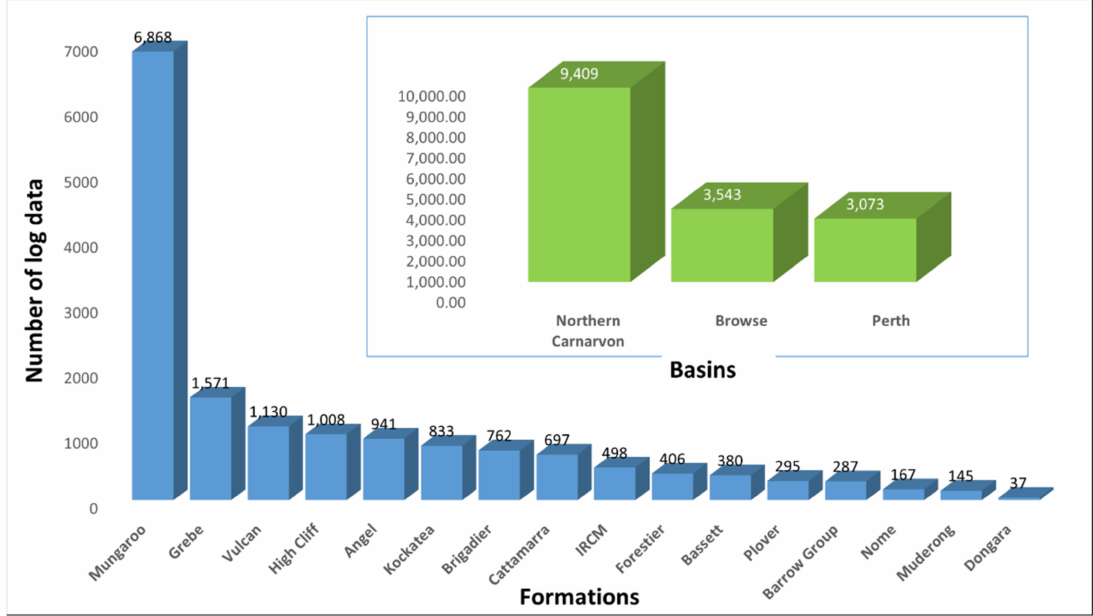
Figure 2. Number of data points for each formation and basins used for this